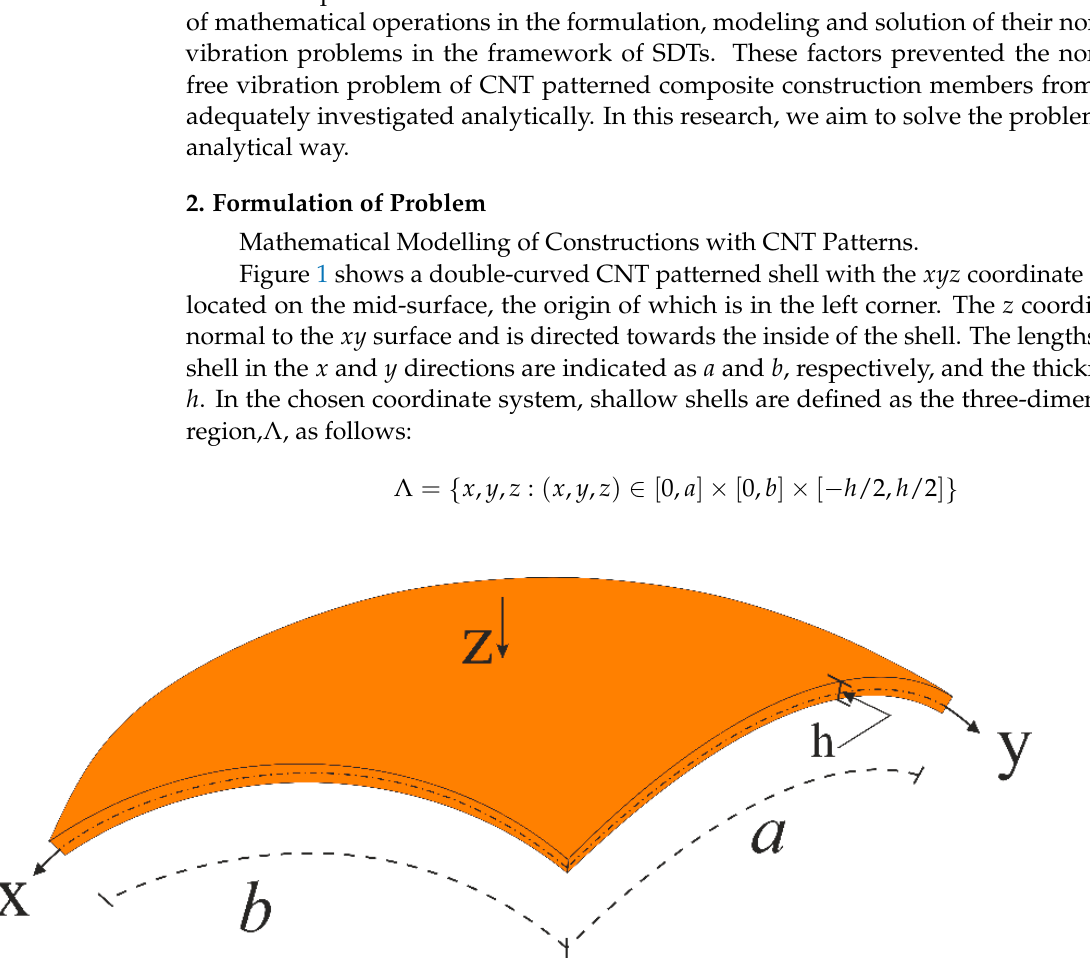
( d ) Figure 2. CNT patterned construction elements: ( a ) spherical shell, ( b ) hypar shell, ( c ) cylindrical panel and ( d ) rectangular plate.